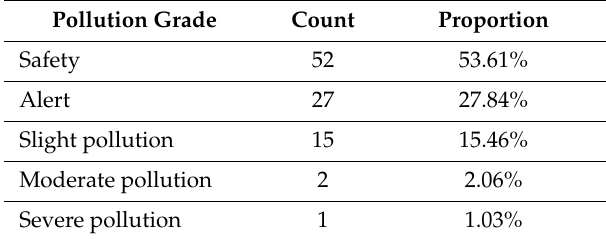
Table 3. Heavy metal pollution grade classification based on the Nemerow composite pollution index